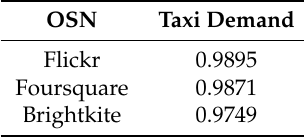
Table 2. Normalized mutual information score between the OSN dataset and the taxi